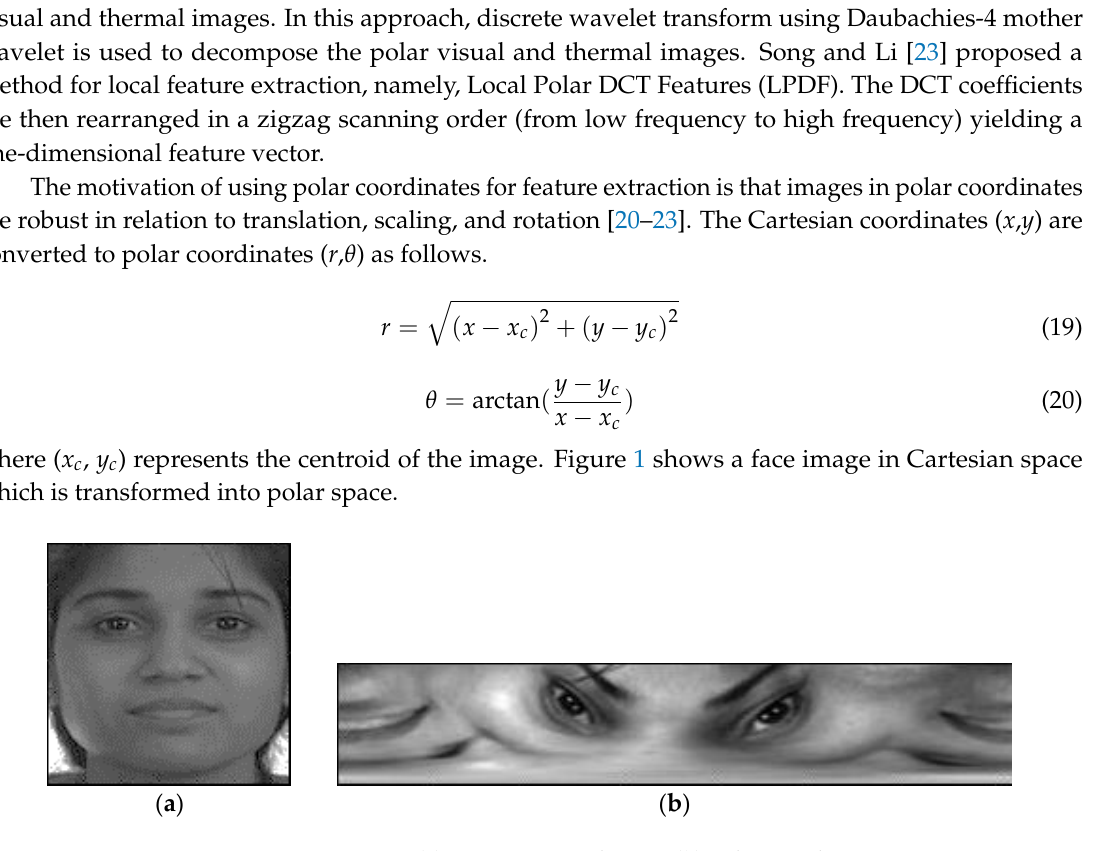
Figure 1. Face image in: ( a ) Cartesian coordinates; ( b ) polar coordinates.